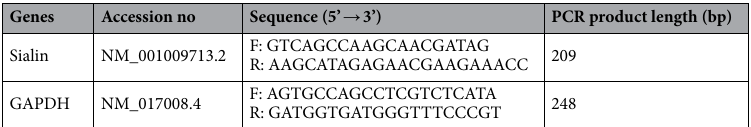
Table 1. Primers sequence used for Real time-PCR. F forward, R